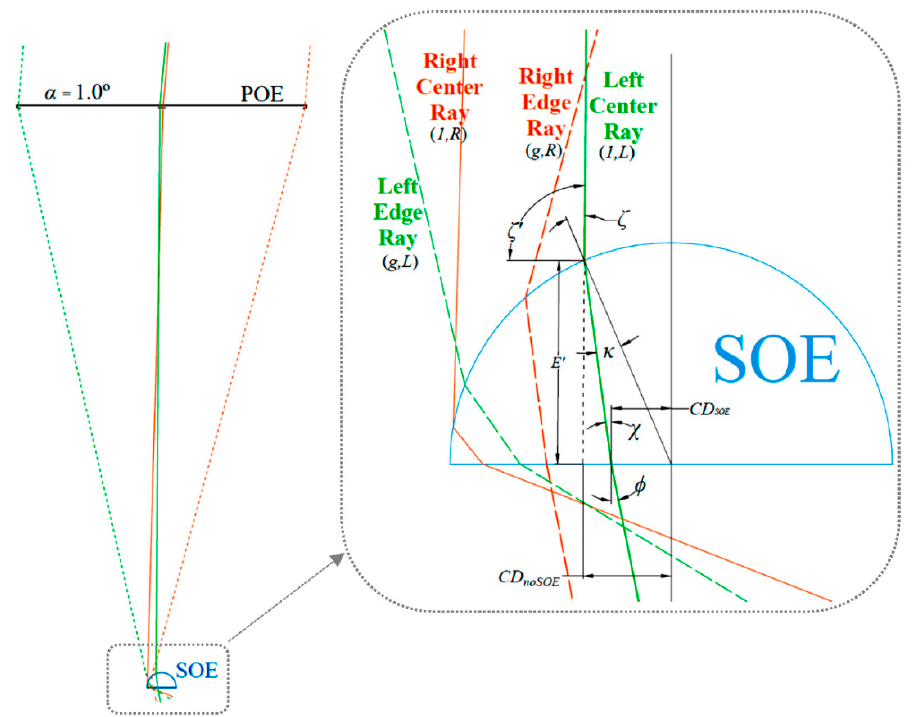
Figure 2. Refraction schematic through the secondary optical element (SOE). Rays from the left side of the lens are in green, and those from the right side are in orange—only four rays are shown for simplicity. (All are to scale except the incident light at the POE surface.) (The black short-dashed line is the projection of the left center ray without the SOE.)